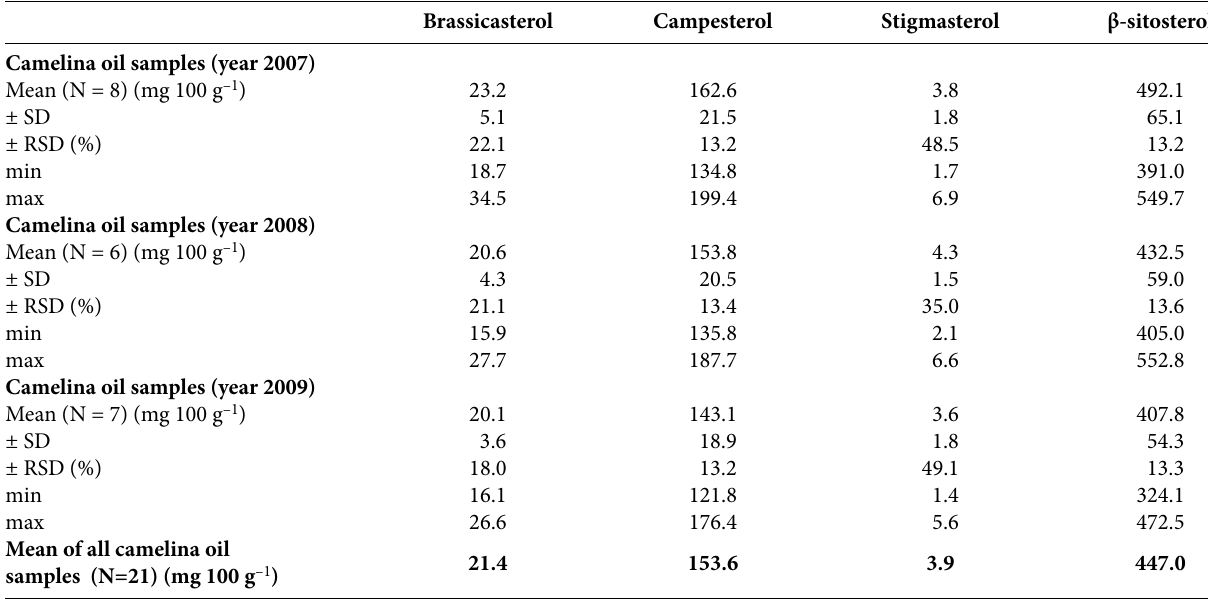
Table 3. Camelina oil samples detailed with year of oil production and sterol composition. Mean, Standard Deviation, Relative Standard Deviation, Minimum and Maximum of Camelina oil samples with regard to the year are given.